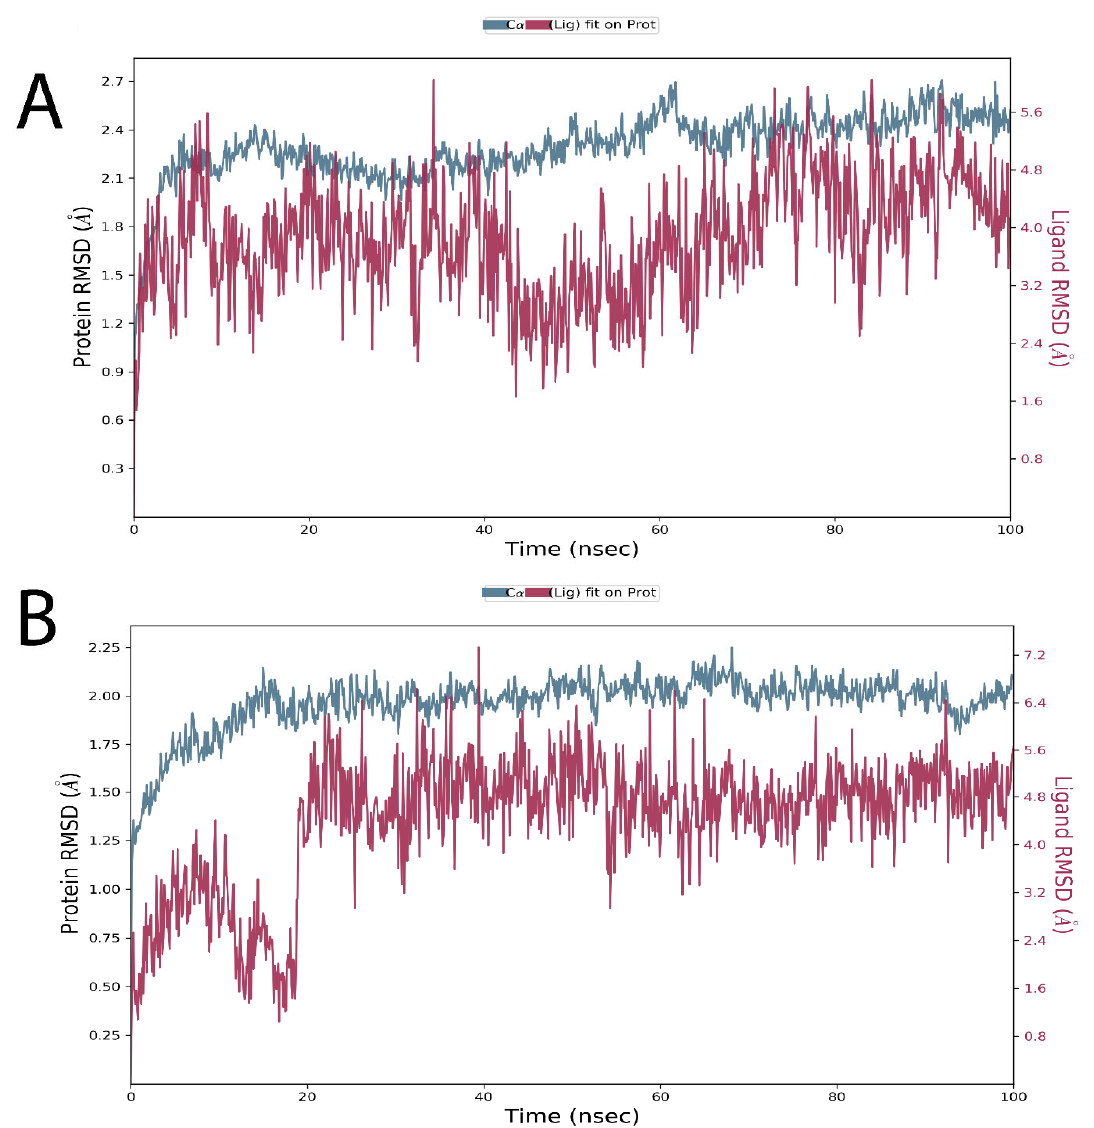
Figure 11. ( A ) RMSD of the C α atoms of α -glucosidase and the ligand Trabectedin with time ( B ) RMSD of the C α atoms of α -glucosidase and the ligand Demeclocycline overtime. The left y axis represents the RMSD variations of the C α atoms of the target protein, and the right y axis represents the ligand’s RMSD variations (red color) over time. Figure 12A,B show atom-wise (ligand) and residue-wise (receptor) root mean square fl uctuation (RMSF) variations of Trabectedin and Demeclocycline. RMSF calculates indi- vidual residue fl exibility during simulation. Due to more fl uctuation, the residues at N- and C-terminals are free, and four peaks in the Figure 12A lower panel and one in 11 B show higher variations in the RMSF value, indicating coil or loop regions. In contrast, lesser fl uctuation peaks show 𝛼 -helices or 𝛽 -sheets, and the areas with very minute fl uc- tuations are binding site residues that are primarily conserved. Except for the higher loops, most residues of α -glucosidase maintain an RMSF value <2.5 Å. The RMSF of both ligand atoms with respect to the α glucosidase is maintained at <2.0 Å for most atoms. RMSF local fl uctuations based on the composition of secondary structures such as helixes (15.17%) and 𝛽 -strands (25.23%) of 40.41% and 59.59% are loops and coils that exhibit higher fl uctuations.